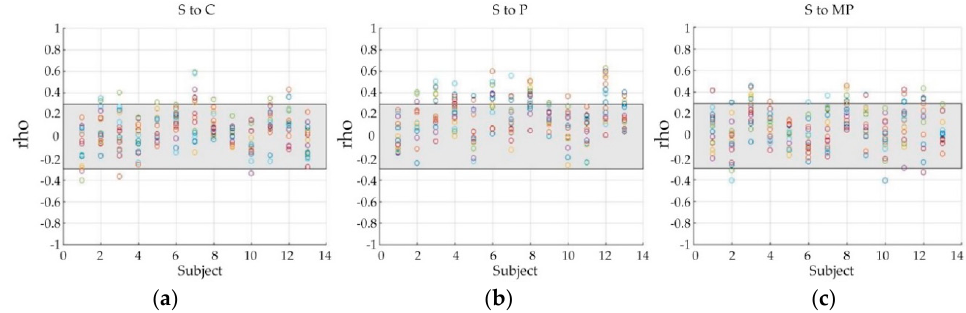
Figure 4. Plots of correlation between the signals for different pain perception levels, and corresponding ratio of the number of points located outside of the grey zone (the weak relationship boundary) to that of points located inside the grey zone. Horizontal axis represents subjects and vertical axis represents spearman’s correlation coefficients (rho). Each color circle indicates the correlation between the data of a specific channel and the grey area shows the weak correlation zone bounded by 0.3 and − 0.3: ( a ) S to C is 0.10; ( b ) S to P is 0.27; ( c ) S to MP is 0.15.